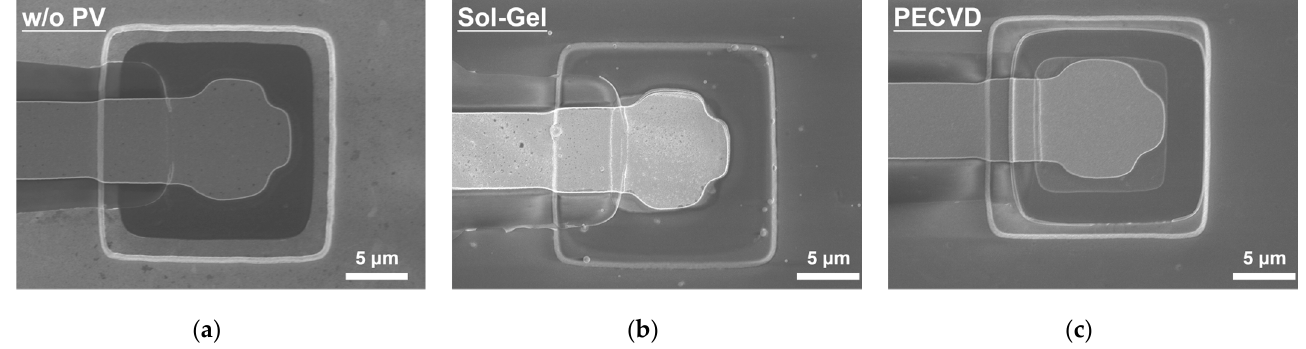
Figure A1. SEM images of Micro-LEDs ( a ) without passivation, ( b ) with sol-gel SiO 2 passivation, ( c ) with PECVD SiO 2 passivation.